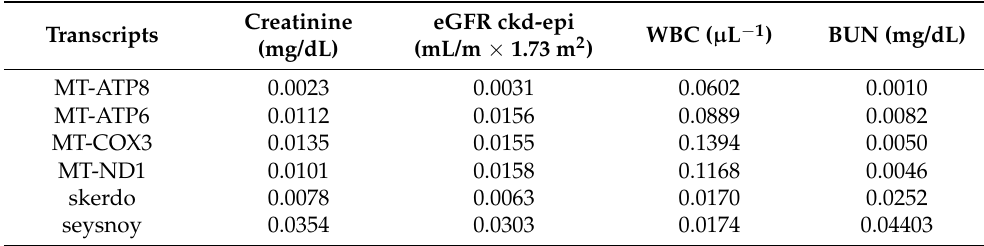
Table 3. p -Values of Spearman correlation analysis between the expression levels of analyzed tran- scripts and clinical patients’